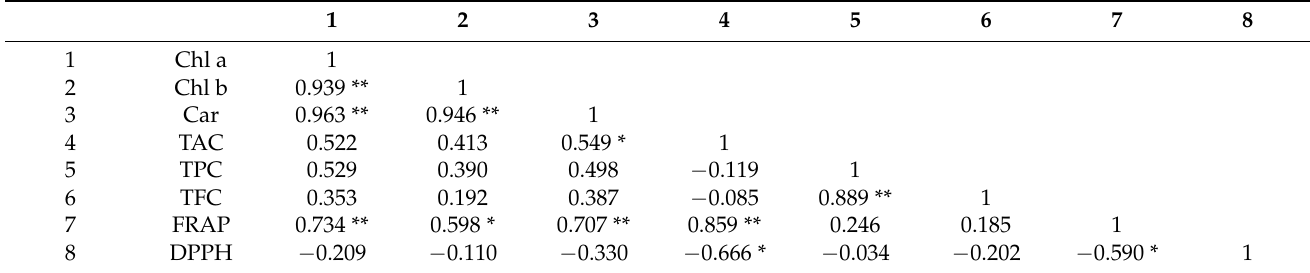
Table 4. Significant Pearson’s correlation between secondary metabolites and antioxidant activities. The (*) indicates significant difference at p ≤ 0.05, while (**) indicates significant different at p ≤